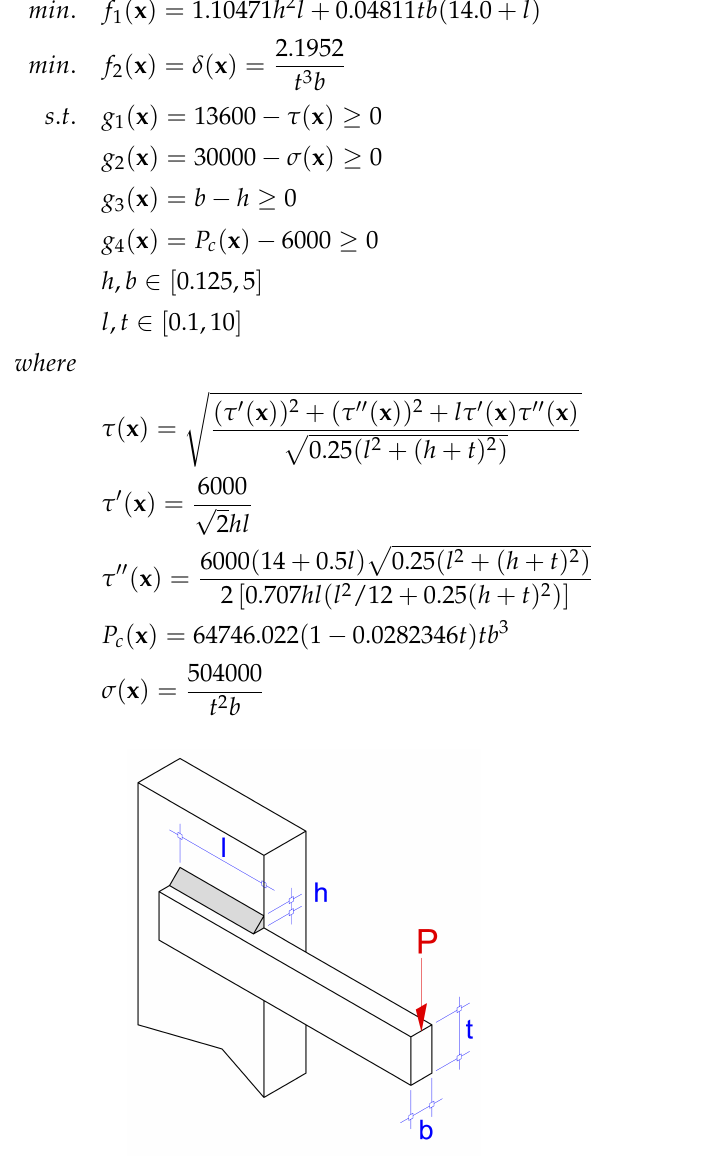
Figure 5. Welded beam design